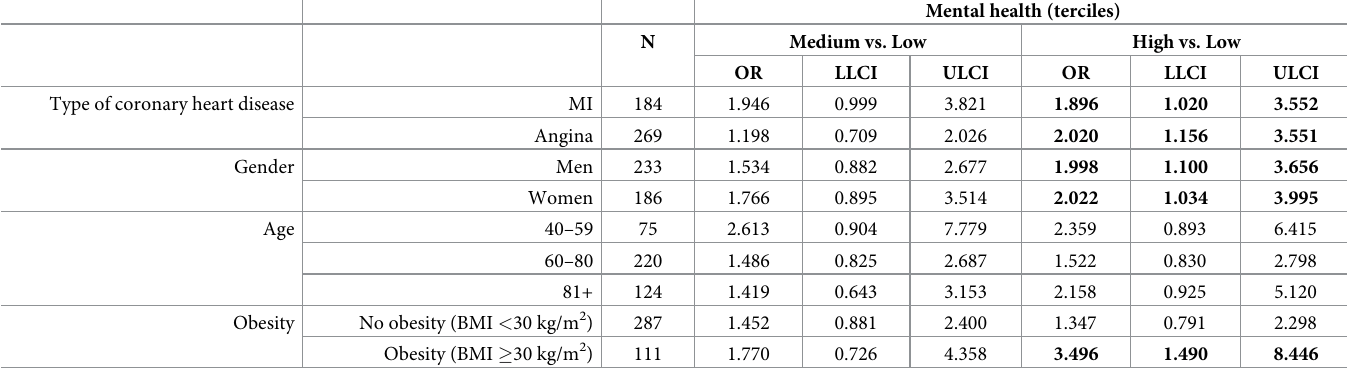
Table 4. Relationship between mental health scores and unhealthy behaviors from simple regression analyses as a function of type of CHD, gender, age group, and the presence of